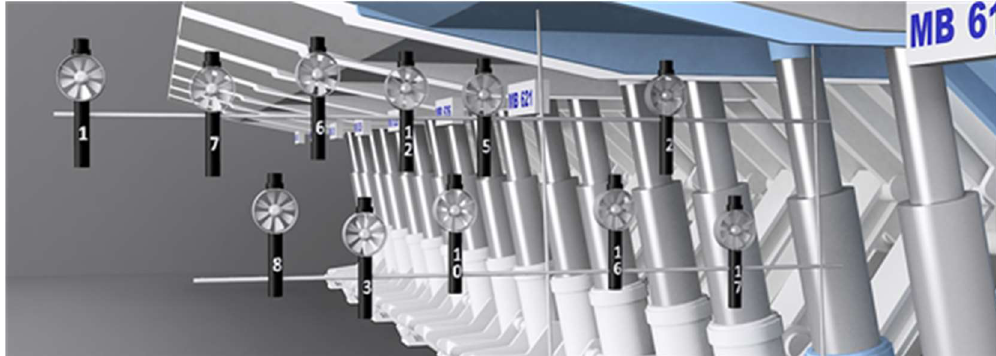
Figure 6. Location of additional sensors and the multi-point system in longwall Cw-4.